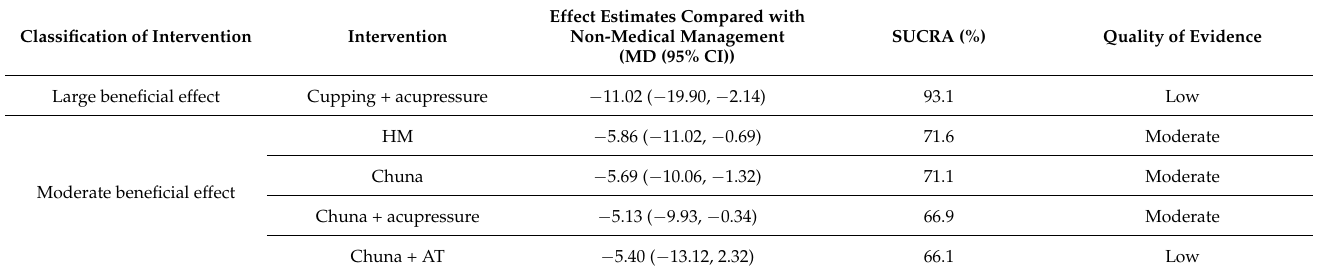
Table 4. GRADE approach using a partially contextualized framework: body